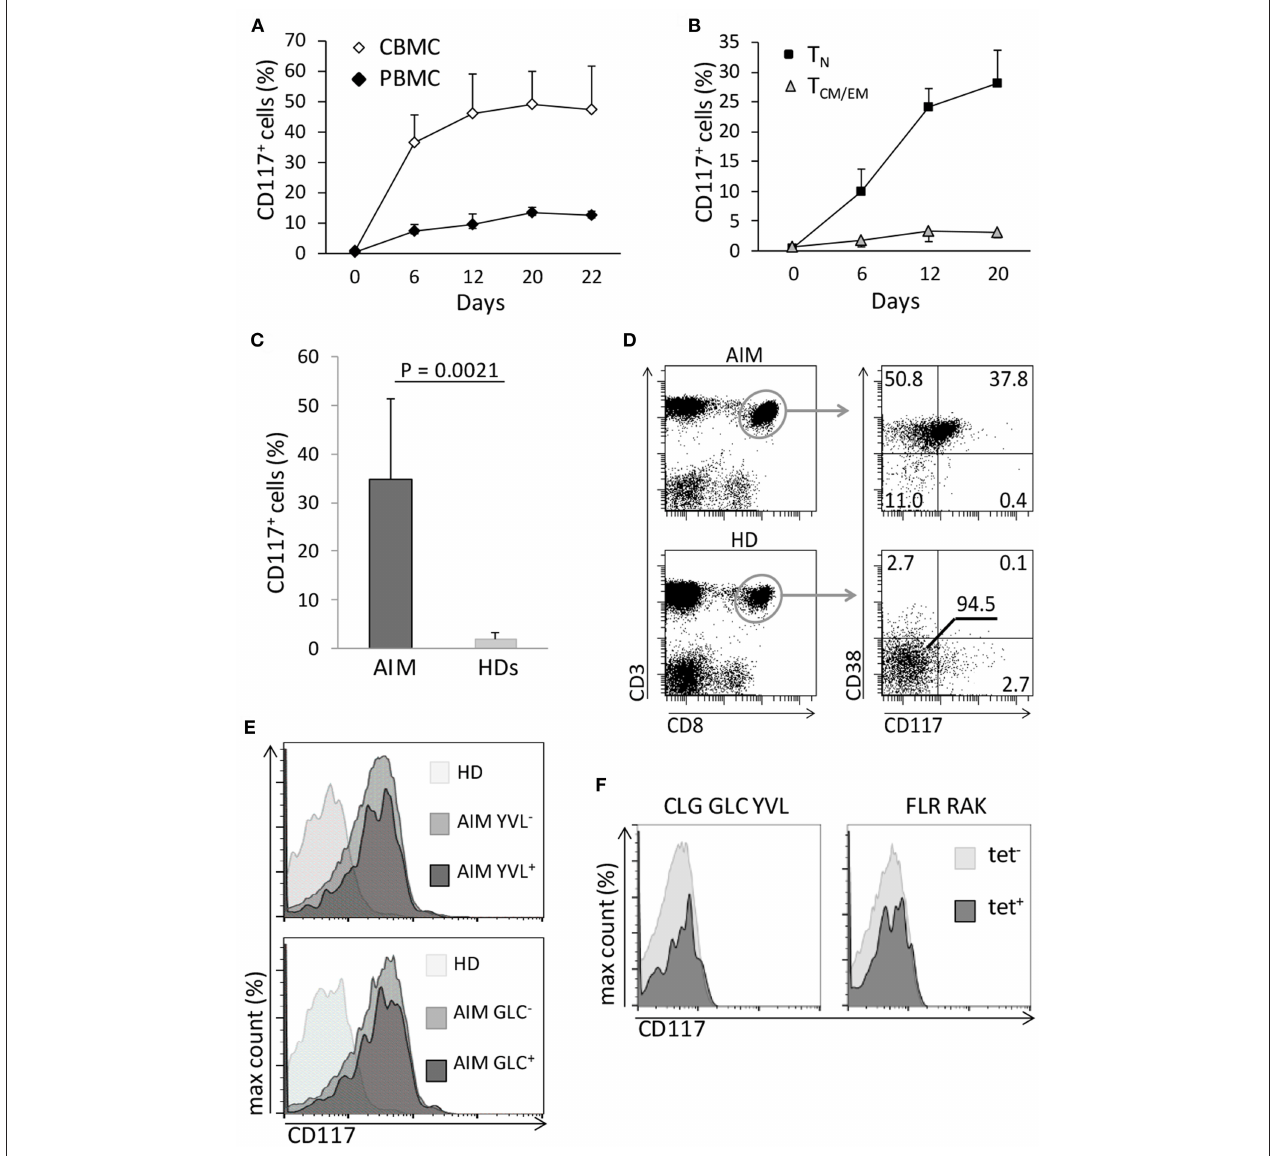
FIGURE 3 | Only T N have the potential to express CD117, and the phenomenon can occur in vivo. (A) CBMC and PBMC were activated and the percentage of CD8 + T cells expressing CD117 was recorded at the indicated time points. Data are from three independent samples. (B) Purified CCR7 + /CD45RA + CD8 + T N and CD45RA − CD8 + T CM / EM from PB of adult donors were activated and CD117 expression recorded at the indicated time points. Data are from three independent samples. (C) Expression of CD117 was measured in PB CD8 + T cells from six patients with AIM and from six healthy donors (HDs). (D) Expression of CD117 and CD38 was measured in PB CD8 + T cells from three patients with AIM and from three HDs. Single representative experiment. (E) PBMC from three patients with AIM, different from those in (D) and all expressing HLA A2, and from three EBV-negative HD were stained with YVL (upper panel) and GLC (lower panel) tetramers. The expression of CD117 is shown in CD8 + T cells from an HD and in either tetramer-positive or tetramer-negative CD8 + T cells from an AIM patient. Single representative experiment. (F) PBMC from three EBV seropositive HDs expressing the appropriate HLA alleles were stained with tetramers specific for the HLA A2-restricted CLG, GLC, and YVL peptides (left panel) or for the HLA B8-restricted FLR and RAK peptides (right panel). The expression of CD117 is shown in CD8 + T cells from tetramer-positive and tetramer-negative CD8 + T cells. Single representative